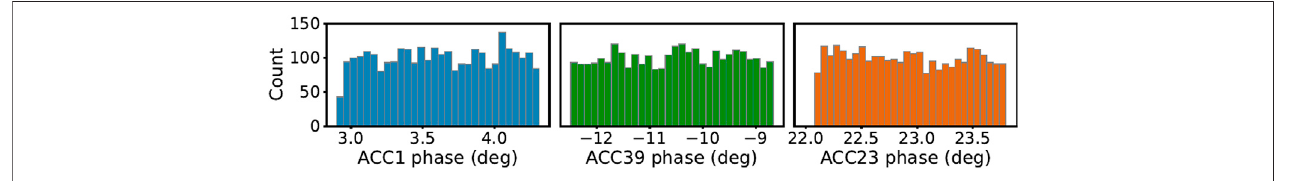
FIGURE 6 | Histograms of the scanned parameters for the dataset shown in Figure 5 . The total number of data points is about 3000.